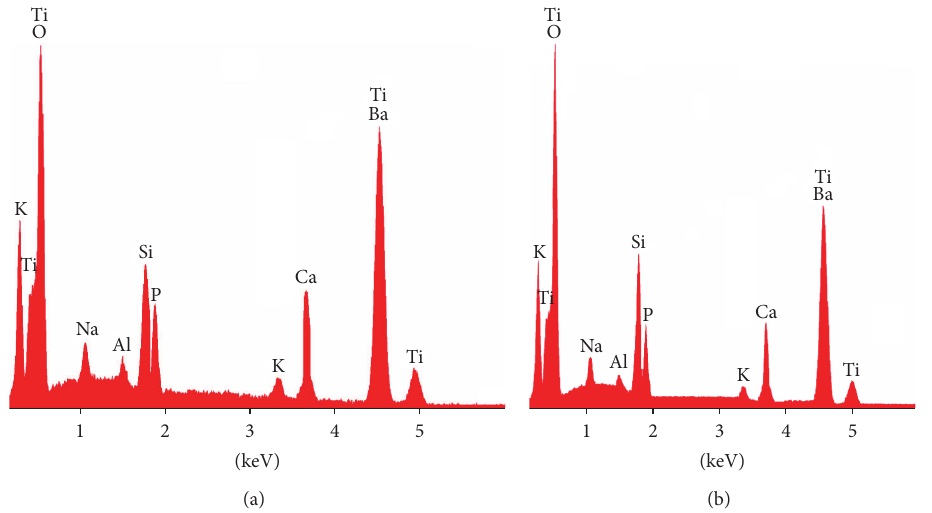
Figure 2: EDS spectrum of Ti-Enamel (a) and Ti-PDMS-Enamel (b)